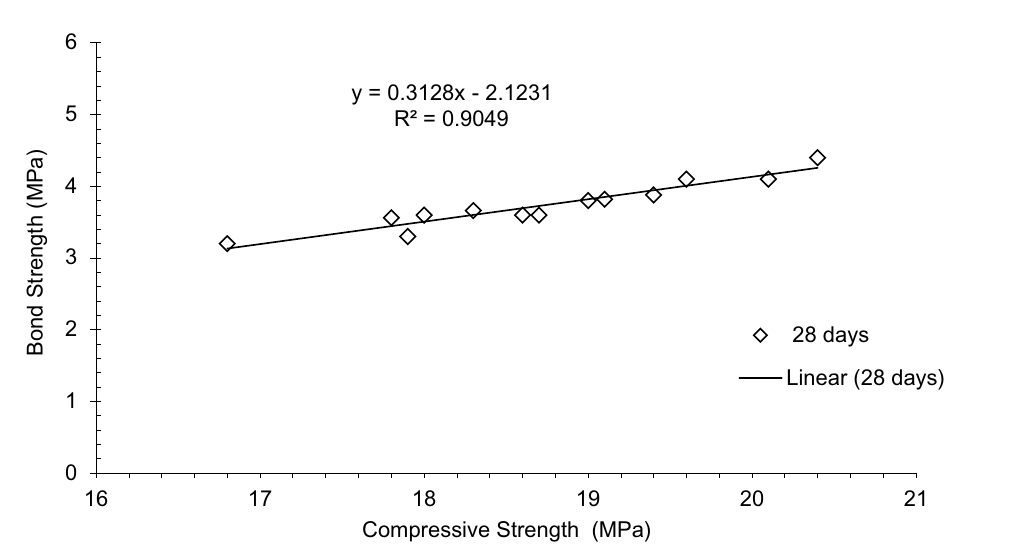
Figure 24. Co-relation between compressive and pull out/bond strength